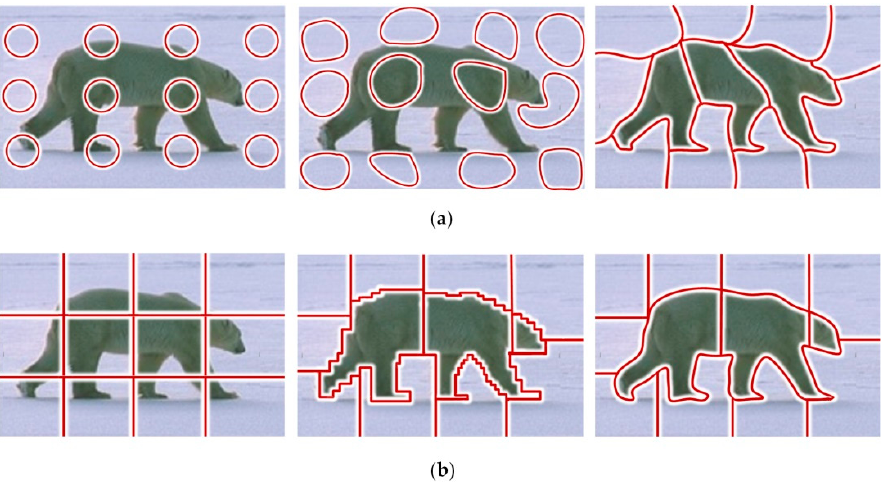
6 of 21 Figure 2. Schematic illustration of BACA superpixel generation framework. ( a ) Input image; ( b )